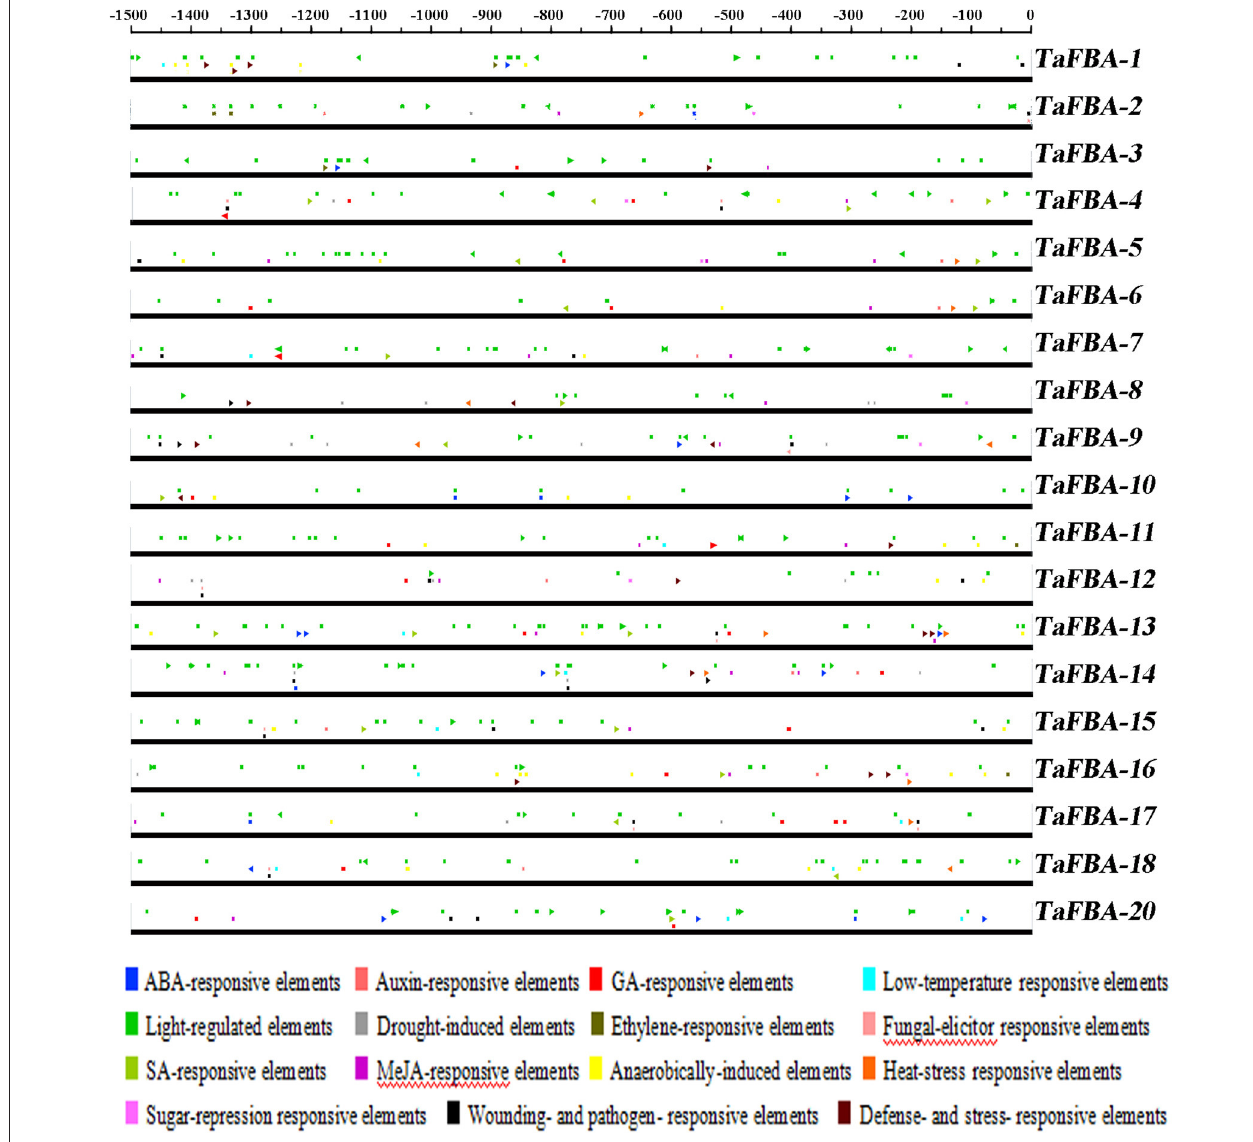
FIGURE 5 | Phytohormone- and stress-responsive cis-elements in the promoter regions of TaFBA genes. 15 Putative ABA-responsive elements (ABRE), Auxin-responsive elements (ARE), GA-responsive elements (GARE), Low-temperature responsive elements (LTRE), Light-regulated elements (LRE), Drought-induced elements (DIRE), Ethylene-responsive elements(ERE), Fungal-elicitor responsive elements (FERE), SA-responsive elements (SARE), MeJA-responsive elements (MeJARE), Anaerobically-induced elements (AIRE), Heat-stress responsive elements (HSRE), Sugar-repression responsive elements (SSRE), Wounding-and pathogen-responsive elements (WPRE), and Defense- and stress-responsive elements (DSRE) core sequences in the 1,500-bp promoter regions of TaFBA genes were predicted using Plant CARE. The lines denote promoter sequences. The elements represented by different colours are indicated above the